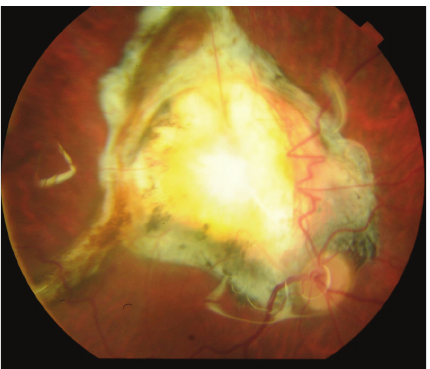
∗ BCVA: best corrected visual acuity. ∗∗